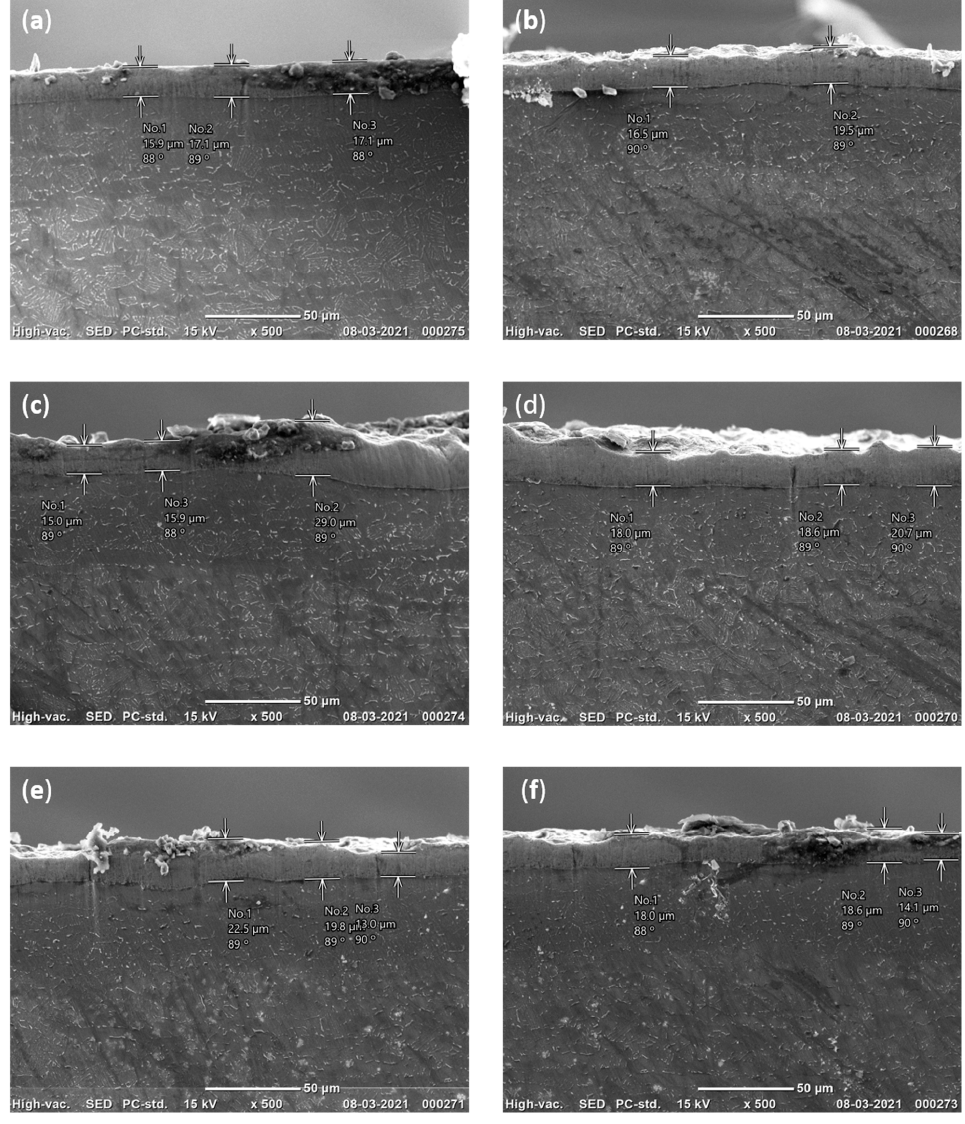
Figure 10. SEM image of cross-section EDC Coating for six experiments shown in the order of ( a ) to ( f )